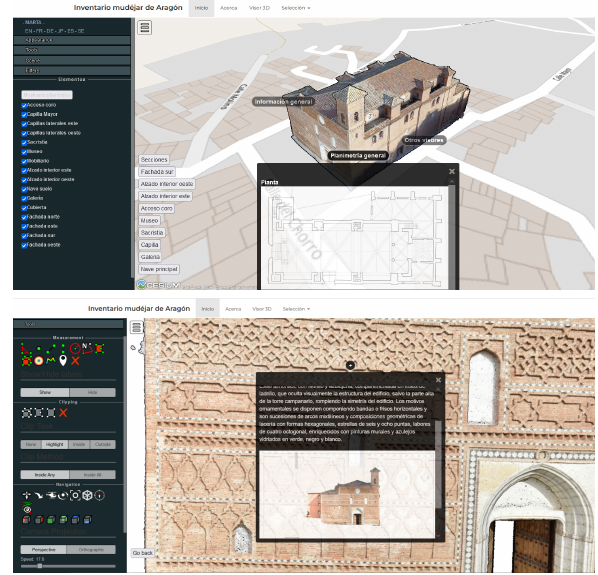
Figure 14. WebGL environment: examples of complementary information associated to (top) the general point cloud view and (bottom) an specific architectural